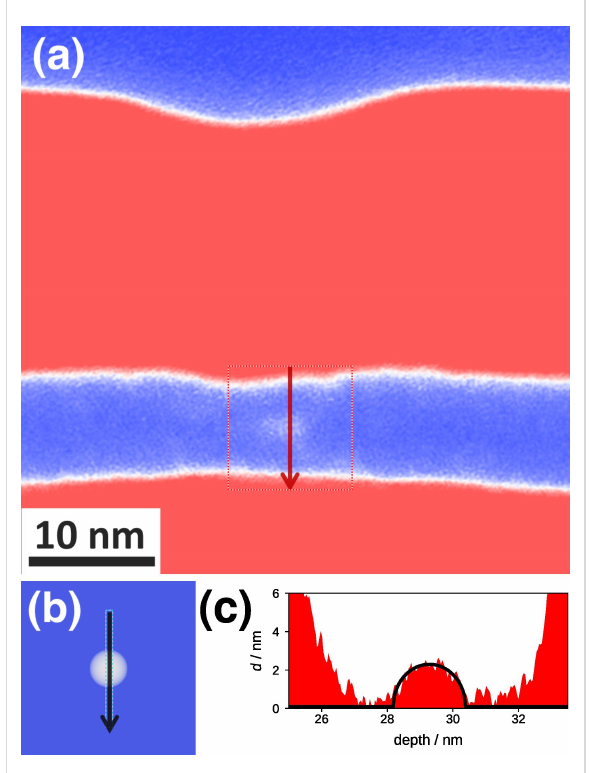
Figure 6: Detection of a single Si NC in SiO 2 . (a) Si plasmon-loss filtered TEM image. A single Si NC (white) in the center of the buried oxide layer (blue) vertically aligned with the sputter crater of the Ne + ir- radiation in the top Si layer (red) is visible. (b) Simulation of the ex- pected projected thickness for a 2.2 nm diameter Si NC. (c) Compari- son of the projected thickness d of a single Si NC obtained from exper- iment (a) and simulation (b).